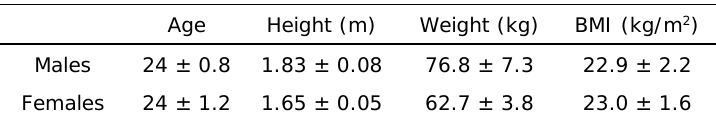
Table 1. Subjects